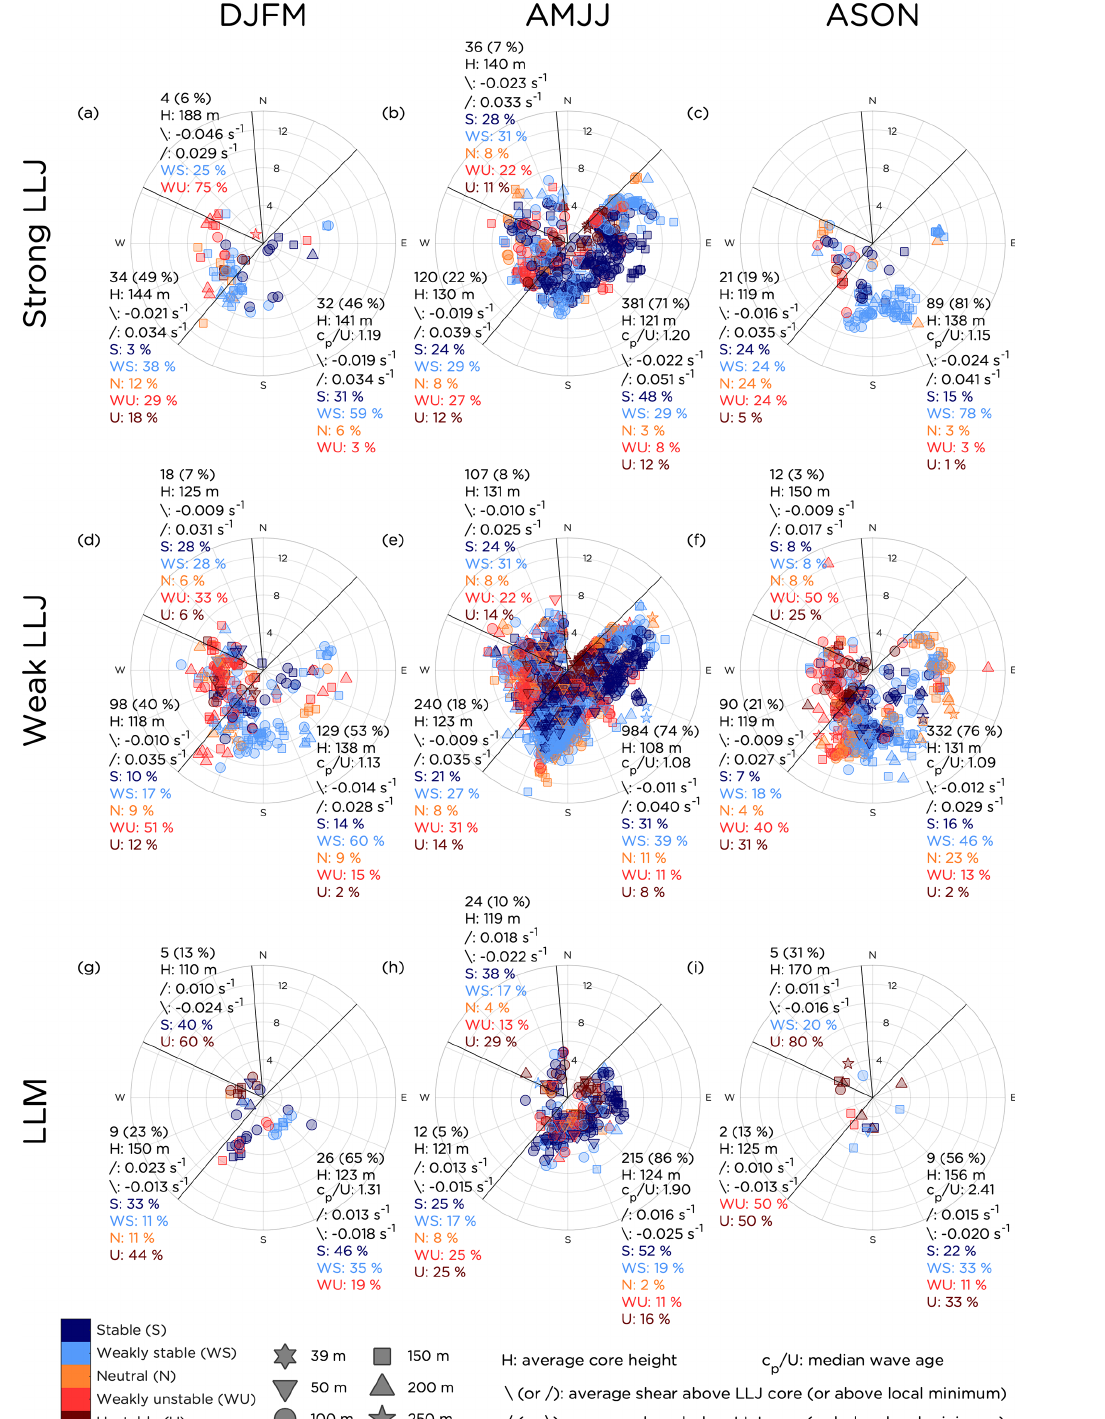
Figure 6. Overview of the seasonal occurrence of all profiles classified as (a, b, c) strong LLJs, (d, e, f) weak LLJs and (g, h, i) LLMs. The left column represents DJFM; the middle represents AMJJ; and the right represents ASON. The position in the polar diagram indicates the wind speed and wind direction at 10m height; the color indicates the stability of the atmospheric surface layer (Sect. 3.6) at the time of the occurrence of the profile. The different symbols indicate the height of the LLJ core or, for the LLMs, the height of the minimum. Statistics regarding the profiles are presented for each sector. Larger versions of the panels can be found in Figs. S3–S11 in the Supplement.